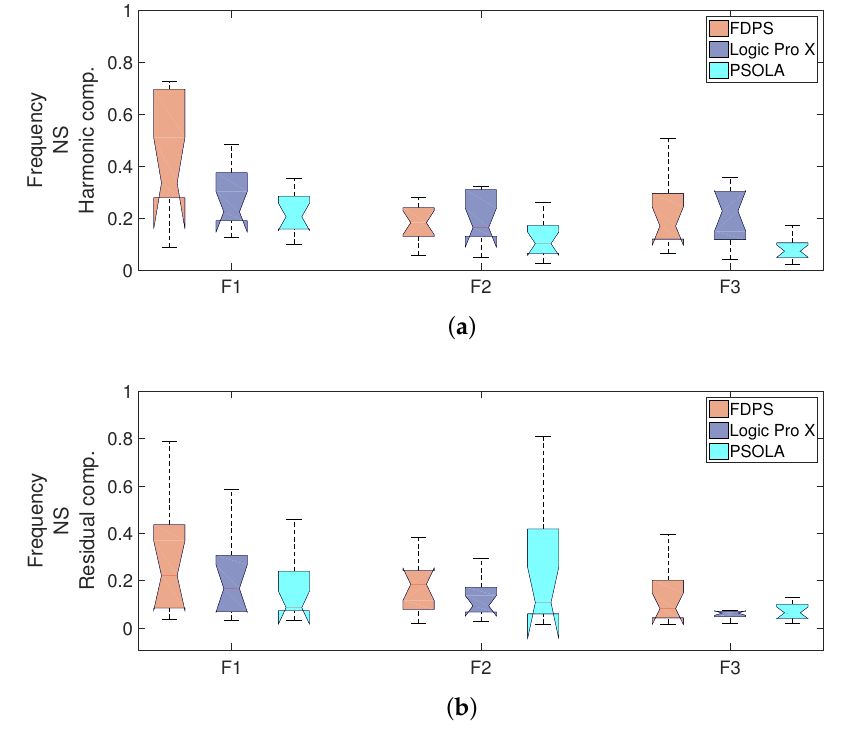
Figure 12. Normalized similarity of the central frequency of the first three formants. ( a ) Harmonic component; ( b ) residual component.